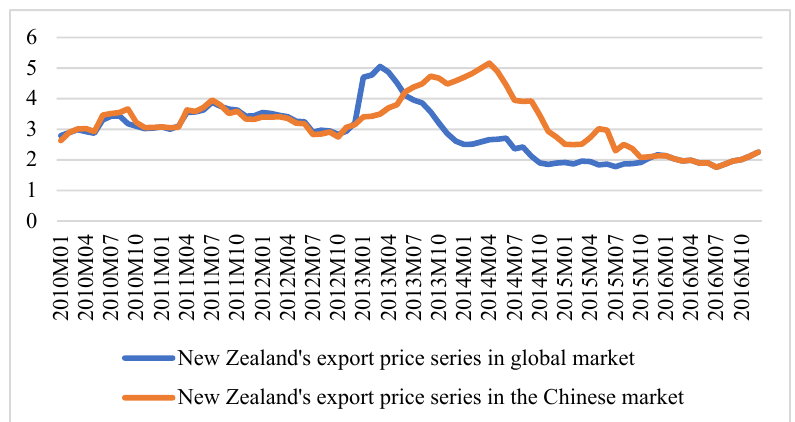
Figure 2. Monthly SMP export prices for New Zealand to the Chinese market and globally between January 2010 and December 2016.